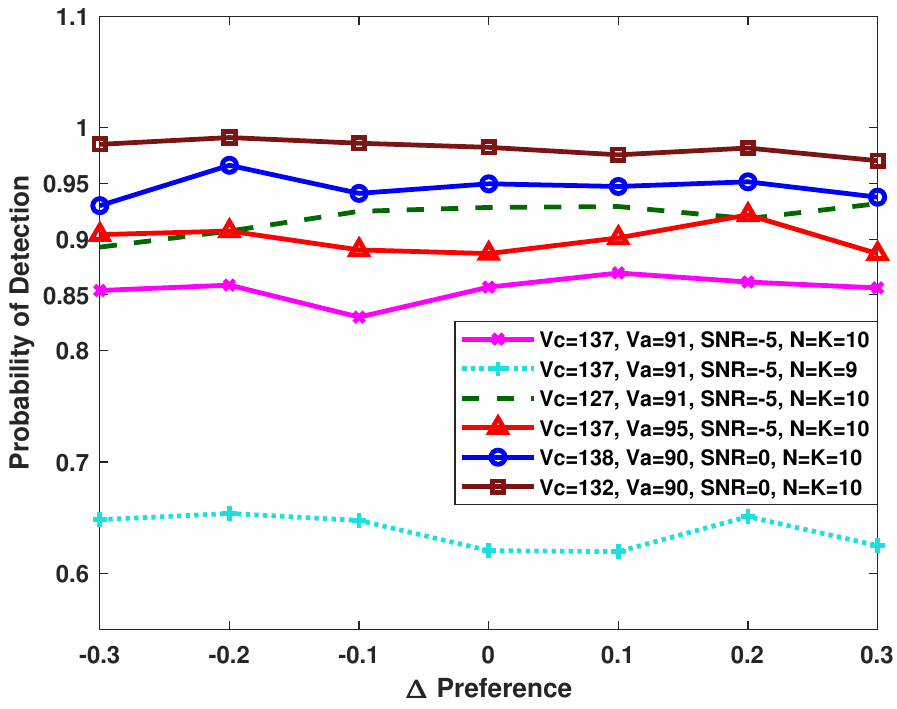
Figure 9. Probability of detection versus different clustering